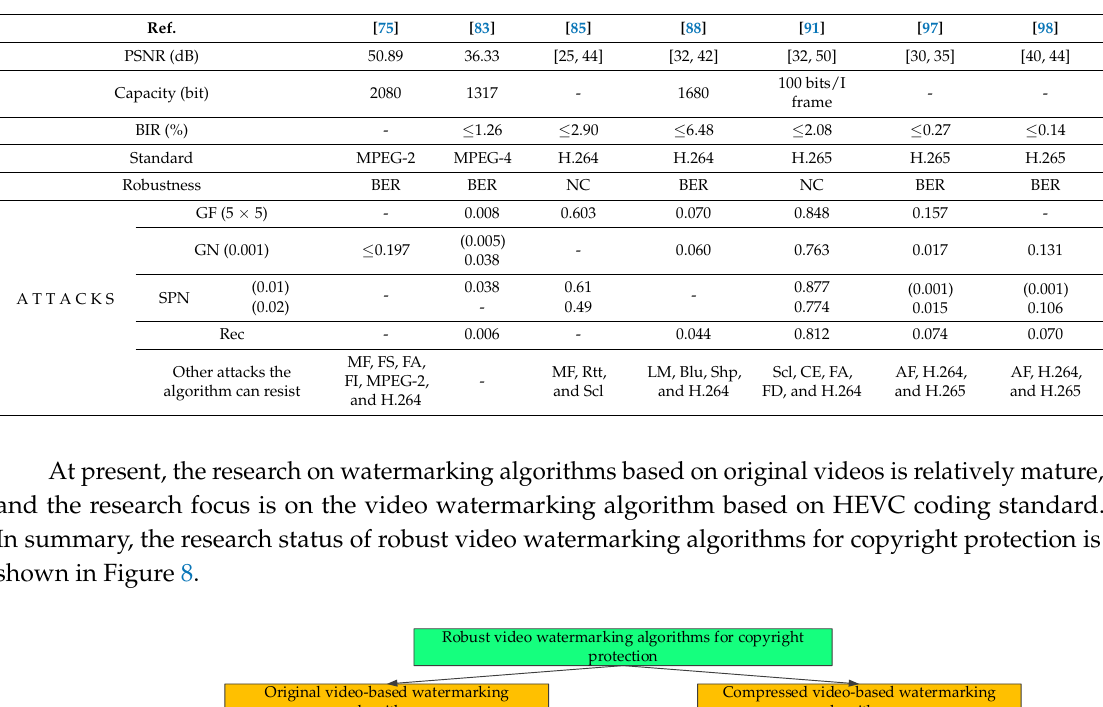
Table 12. Quantitative comparison of invisibility, capacity, BIR, and robustness of several typical algorithms in compressed domain.